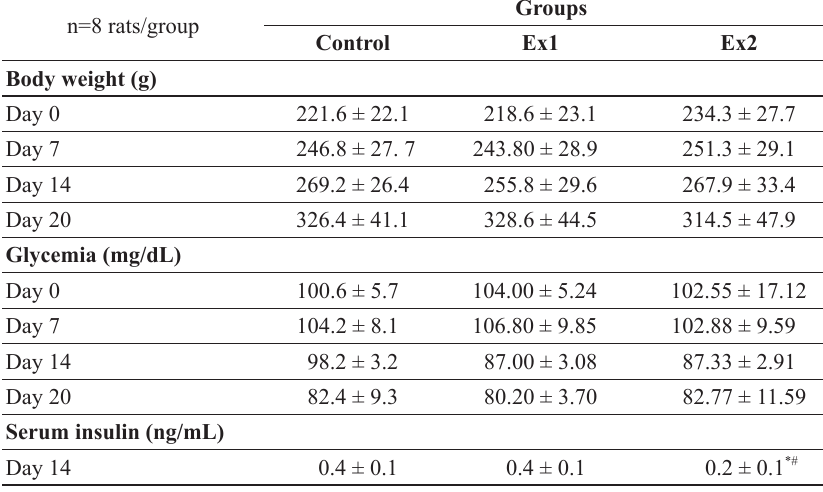
Maternal data during pregnancy of SPA control, Ex1 and Ex2 rats. n=8 rats/group